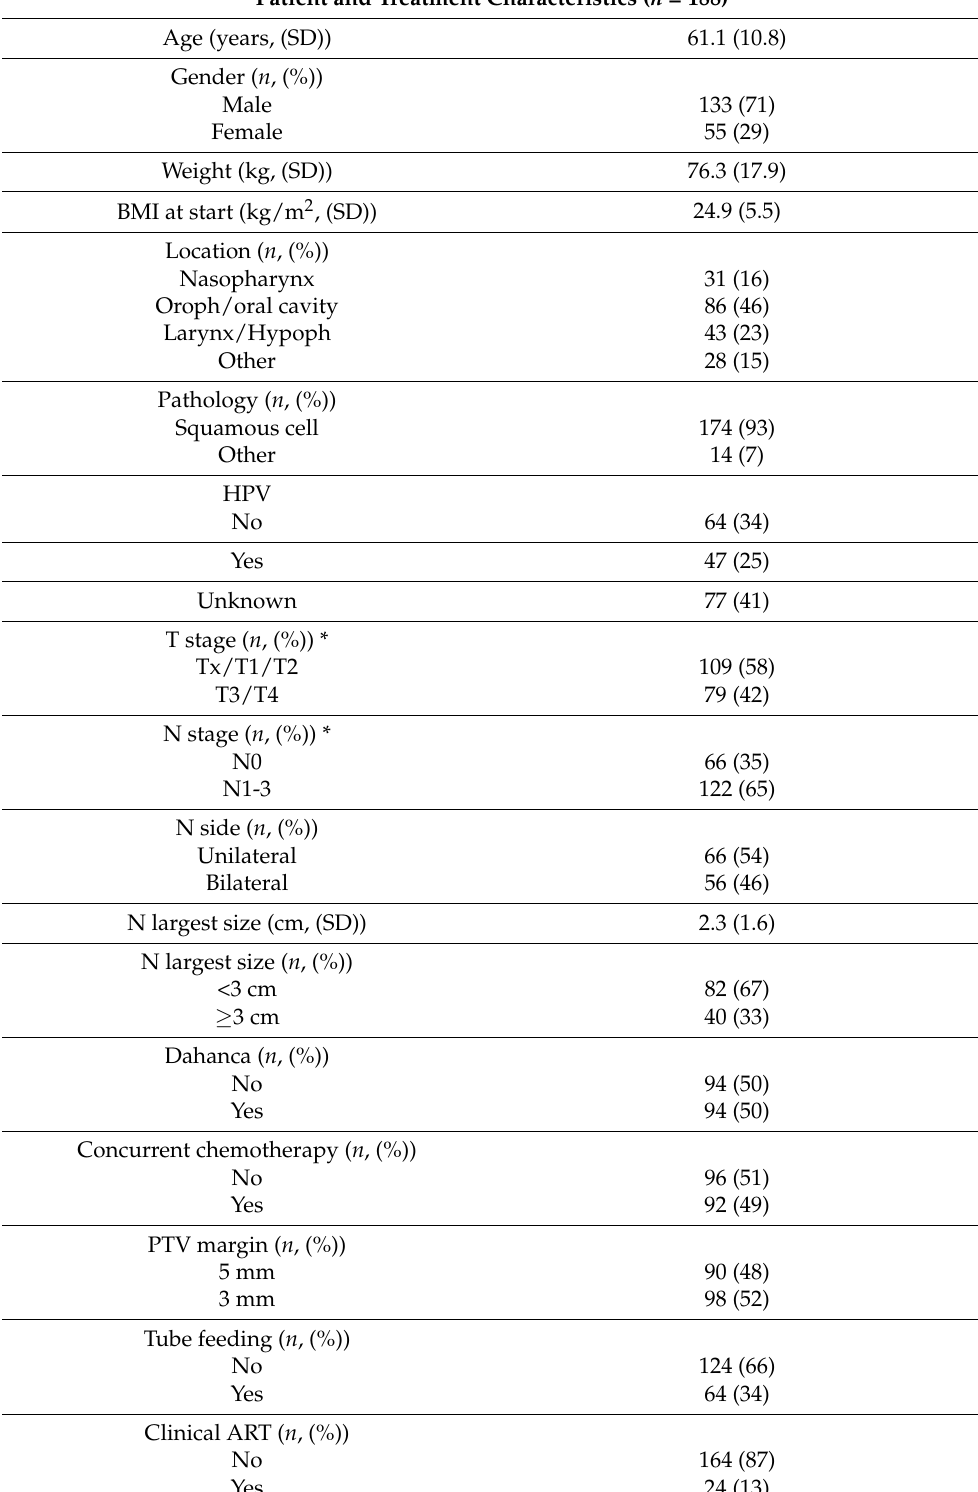
Table 1. Patient